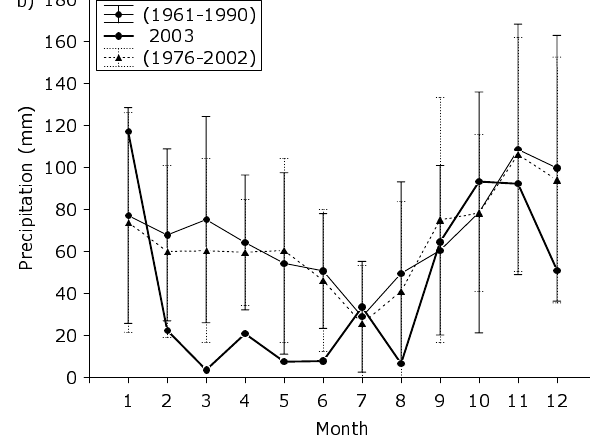
Fig. 2a. Annual cycle of monthly mean air temperature at Split- Marjan for the periods 1961–1990 and 1976–2002 and for the year 2003. Vertical bars represent interannual standard deviations for particular month.